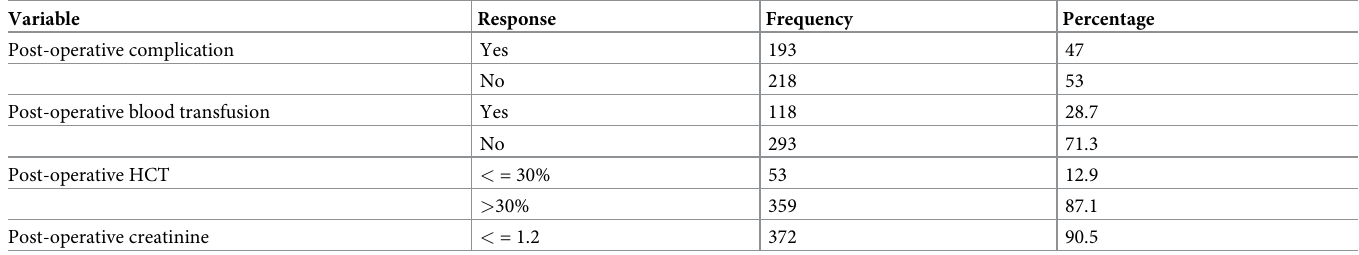
Table 4. Post-operative status of the patient related characteristics among patients who had intestinal anastomosis surgery in Northwest Amhara regional State referral Hospitals, from February 2017 to February 2020.(n = 411).